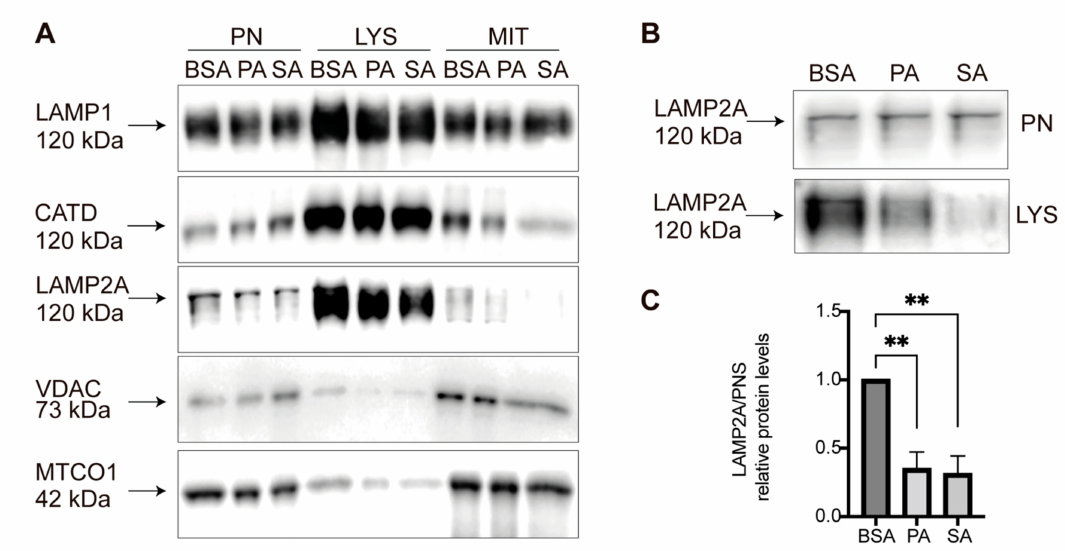
Figure 2. Lysosomal LAMP2A protein levels decrease in POMC-like neurons treated with PA and SA. ( A ) POMC-like neurons (N43/5) were incubated with 100 mM of PA, SA, or vehicle (BSA) for 6 h and a mitochondrial and lysosomal fractionation was carried out according to Ormeño et al. 2020. Post nuclear (PN), lysosomal (LYS), and mitochondrial (MIT) fractions were evaluated by Western blot using LAMP1, CATD, LAMP2, VDAC, and MTCO1 antibodies, as appropriate. ( B ) Representative Western blot comparing the lysosomal LAMP2A protein levels versus the PN fractions after BSA, PA, and SA treatment. ( C ) Quantification of LAMP2A from Figure 2B using ordinary one-way ANOVA ( n = 3). n.s. = non-significant, ** = p <